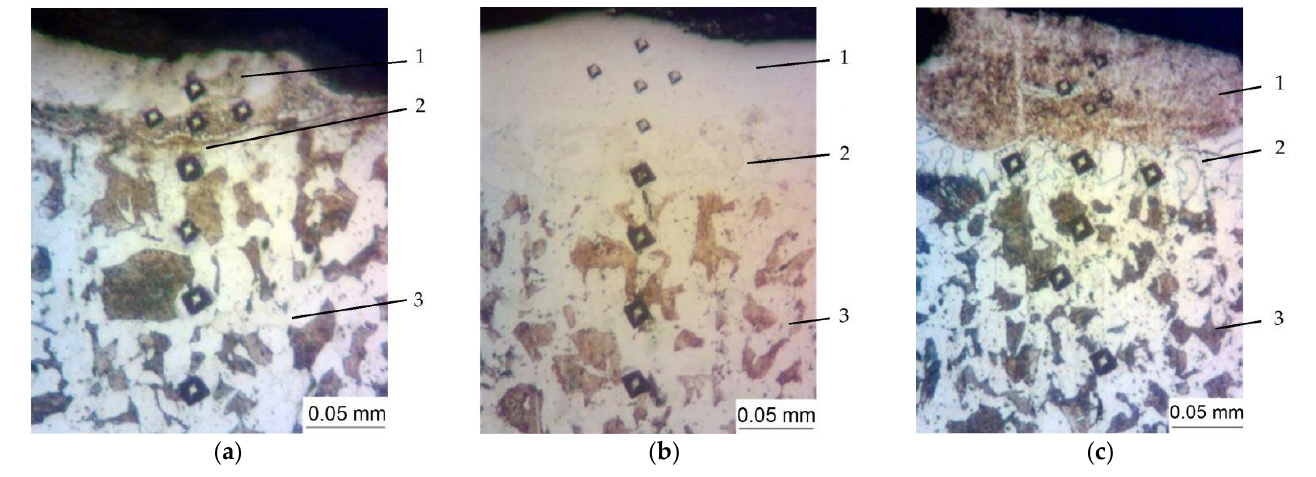
Figure 2. The microstructures of the nitrided surface layers of the steel C22 specimens having the aluminum sublayer and processed with the use of the ESA method by the electrode-tool made of steel C22 at the discharge energy (W р ): ( a ) — W р = 0.13; ( b ) — W р = 0.52 and ( c ) — W р = 3.40 J, 1 —“ white layer ” , 2 — the diffusion zone, 3 — the base metal.